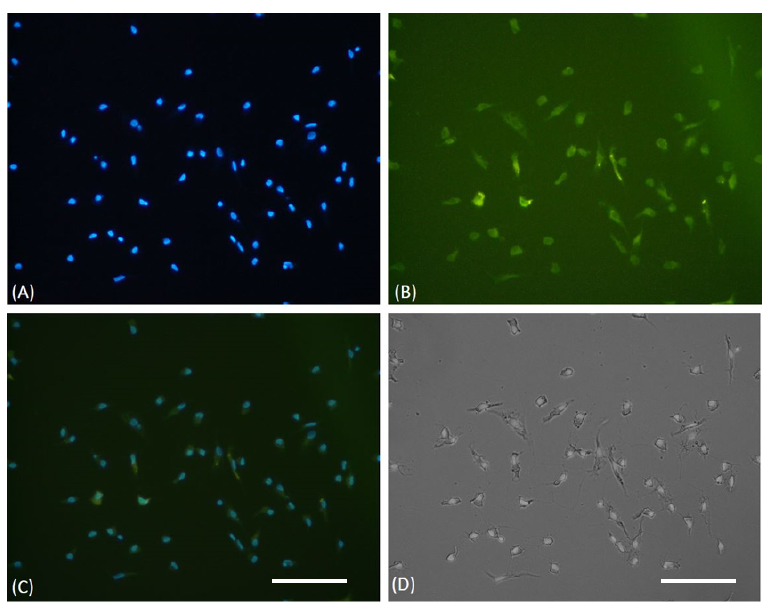
Figure 1. Immunofluorescence characterization of cultured EPCs. ( A ) DAPI staining of cultured EPCs showed viable cells through blue fluorescent of cells nuclei. ( B ) EPCs were confirmed, using FITC-labeled anti-human CD34 expression on immunofluorescence microscope. ( C ) Merged view of DAPI and FITC stained cells . ( D ) The light microscope view showed the spindle shape morphology of EPCs. The white bar represents 50